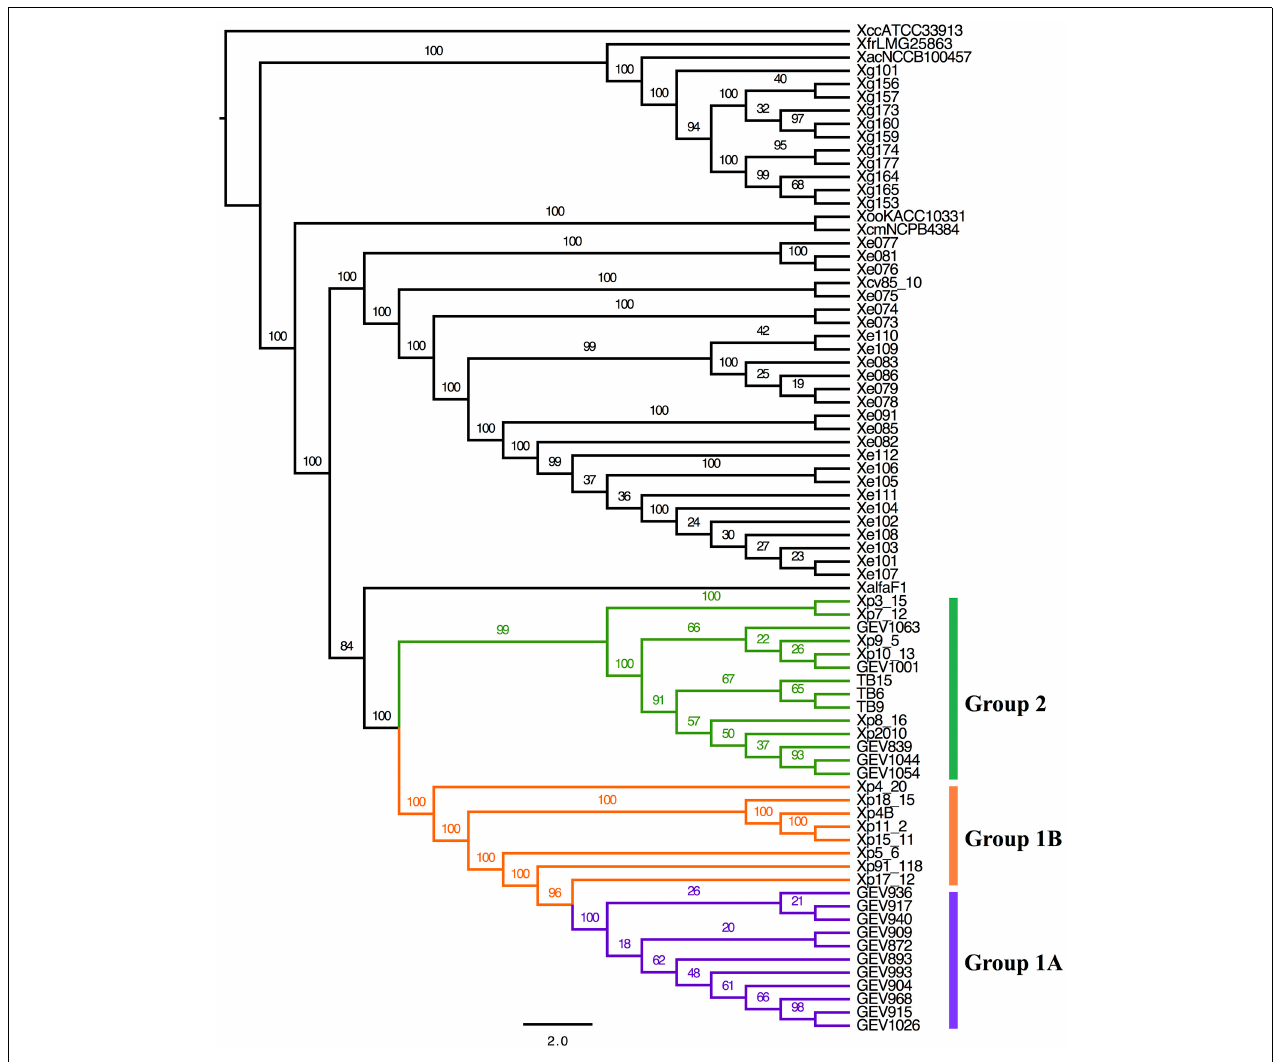
FIGURE 1 | Core genome phylogenetic analysis. Phylogenetic trees obtained by ML (IQTree) analysis, based on partitioned analysis (by codon position) of a total of 916,326 sites (1017 genes families). Branch support